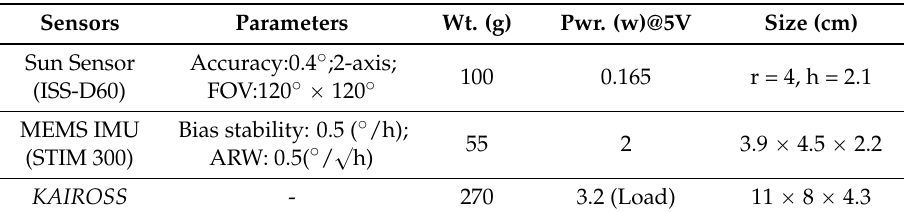
Table 1. Sensor parameters in KAIROSS